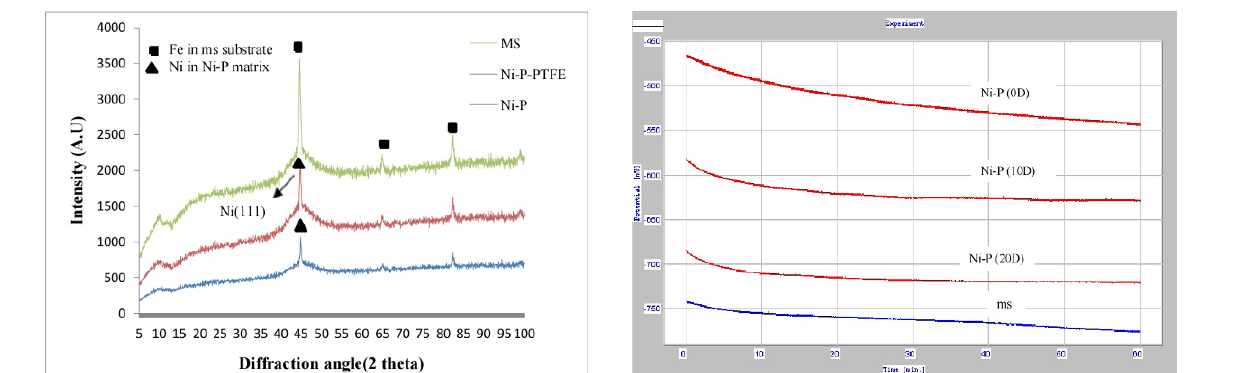
intensity and broad peak at ˜ 44.50° was observed as a result of the nickel and diffraction from (111) planes [14].